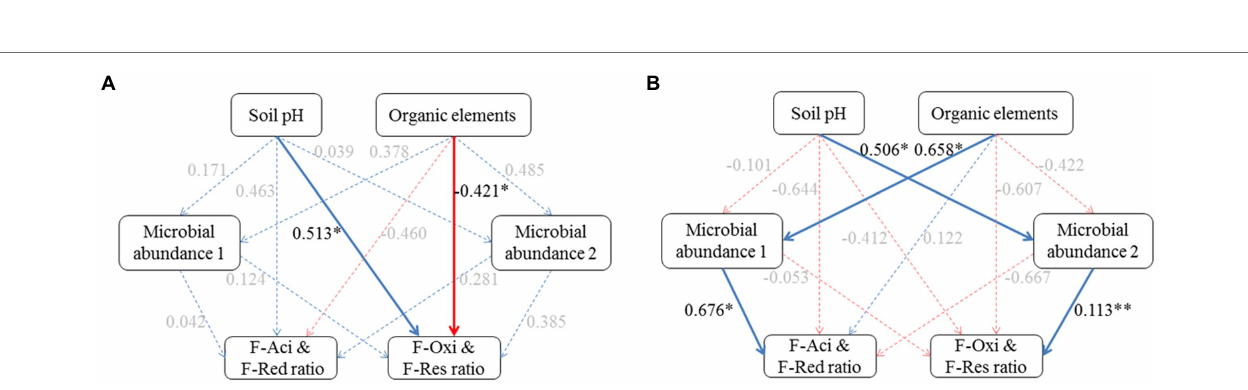
FIGURE 5 | Effects of soil factor and microbial community composition on Cd speciation ratios in the plow layer and plow pan soils. (A) Plow layer. (B) Plow pan. Blue lines and red lines indicate the positive and negative correlations, respectively, and dashed lines indicate the correlations are not at a significant level. Asterisks indicate the significance level: *p < 0.05, **p < 0.01, and *** p <